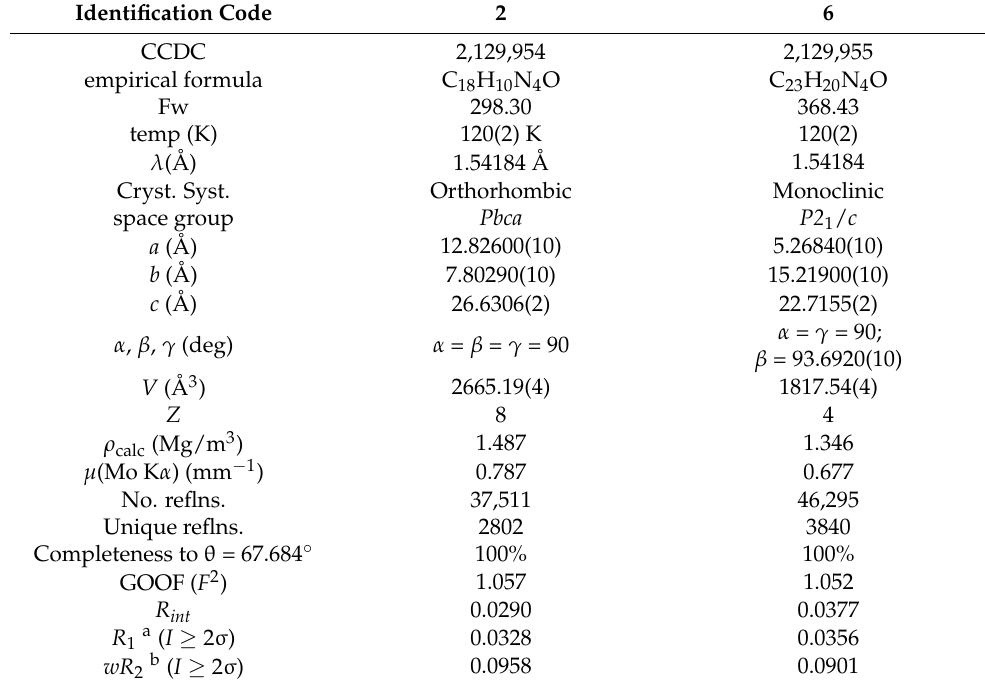
Table 1. Crystal data of 2 and 6 .